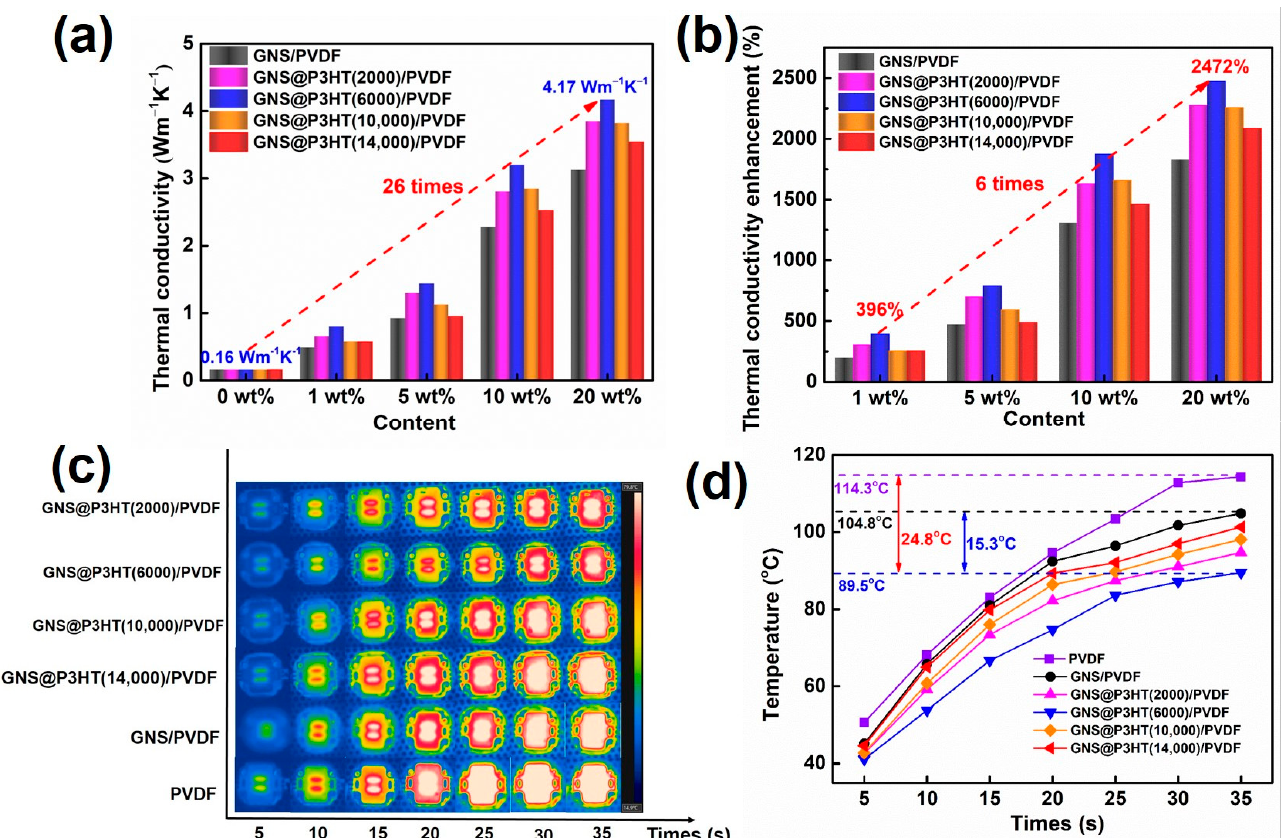
Figure 8. ( a ) The thermal conductivity of GNS@P3HT/PVDF membranes with different filler loadings. ( b ) Thermal conductivity enhancement of GNS@P3HT/PVDF with different filler loadings. ( c ) The infrared thermal images of the light-emitting diode (LED) chips integrated with PVDF, GNS/PVDF, and GNS@P3HT/PVDF. ( d ) The surface temperature curves of LED chips integrated with P3HT@GNS/PVDF in 35 s.